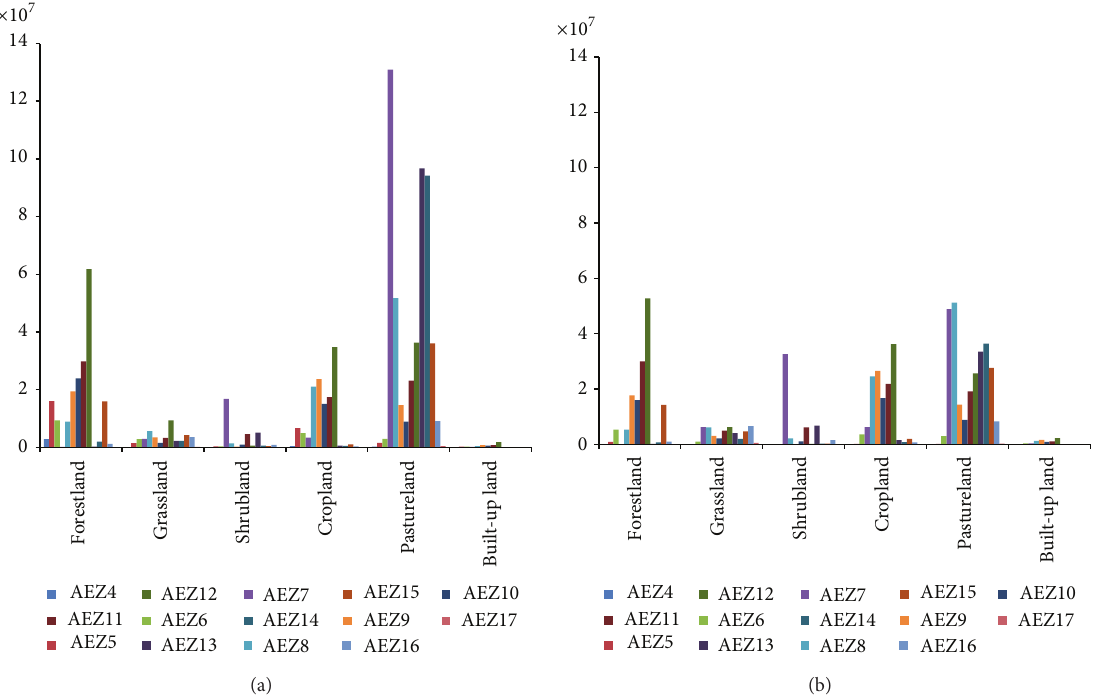
Figure 3: Simulated land use area in 14 AEZs in 2010 using the GCAM model (a) and GTAP-AEZ model (b) (unit: hectare).